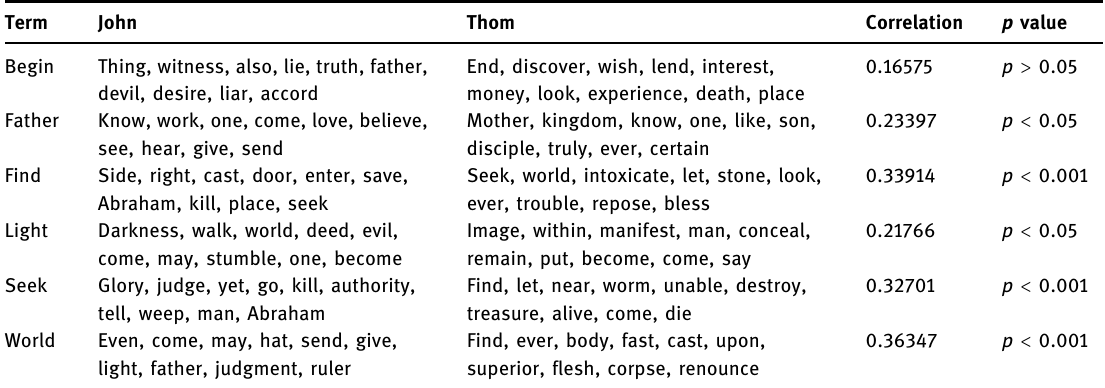
Table 2: Target terms ’ nearest neighbors and correlation